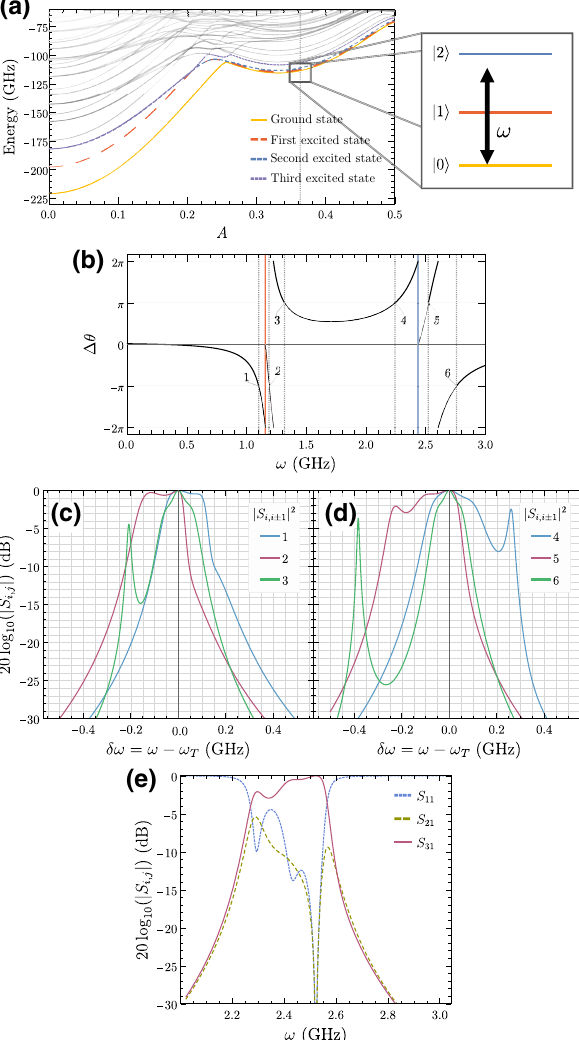
FIG. 8. (a) The energy-level structure at A ≈ 0.36 in region 3. The phase difference (cid:20)θ as a function of driving frequency ω is shown in (b), where dashed vertical lines indicate the nonrecip- rocal target frequencies, enumerated for future reference. The red and blue vertical lines indicate the first and second excited ener- gies, respectively, for the central circuit. The parameters for these plots are as in Fig. 4, except for A ≈ 0.36. For the enumerated nonreciprocal points in (b), we show the transmission bandwidth in (c),(d). For point 5, we show the signal circulation in (e). The parameters are as in (b), where the procedure for determining g , κ , and ω R is identical to that described in Sec. IV